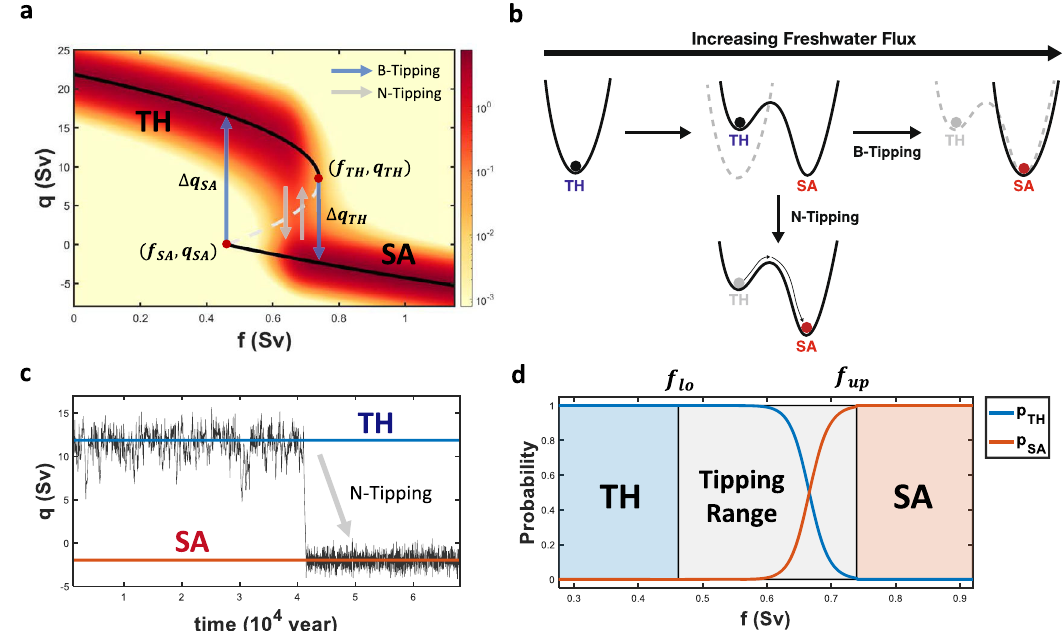
Fig. 1 Tipping behavior in Stommel ’ s model under a stationary freshwater forcing. a Stationary PDF solution of Stommel ’ s model versus the freshwater fl ux forcing (FWF) represented by f . The color denotes q ’ s normalized PDF, and its local maxima and minima are denoted as black-thick and gray-dashed lines, respectively. The blue and gray arrows schematically illustrate B- and N-tipping processes, respectively. Two bifurcation points, ( f TH ; q TH ) and ( f SA ; q SA ), and their change of q during bifurcation ( Δ q TH and Δ q SA ) are marked. b Schematic illustration of potential, V q ð Þ in Eq. (8b) with increasing FWF and associated tipping mechanism. c Example for N-tipping at f ¼ 0 : 73Sv . d The probability of being in TH (blue line) and SA (orange line) states along FWF. The boundaries of the tipping range ( f lo and f up ), which are identical to two bifurcation points ( f TH and f SA ), are marked as a black vertical